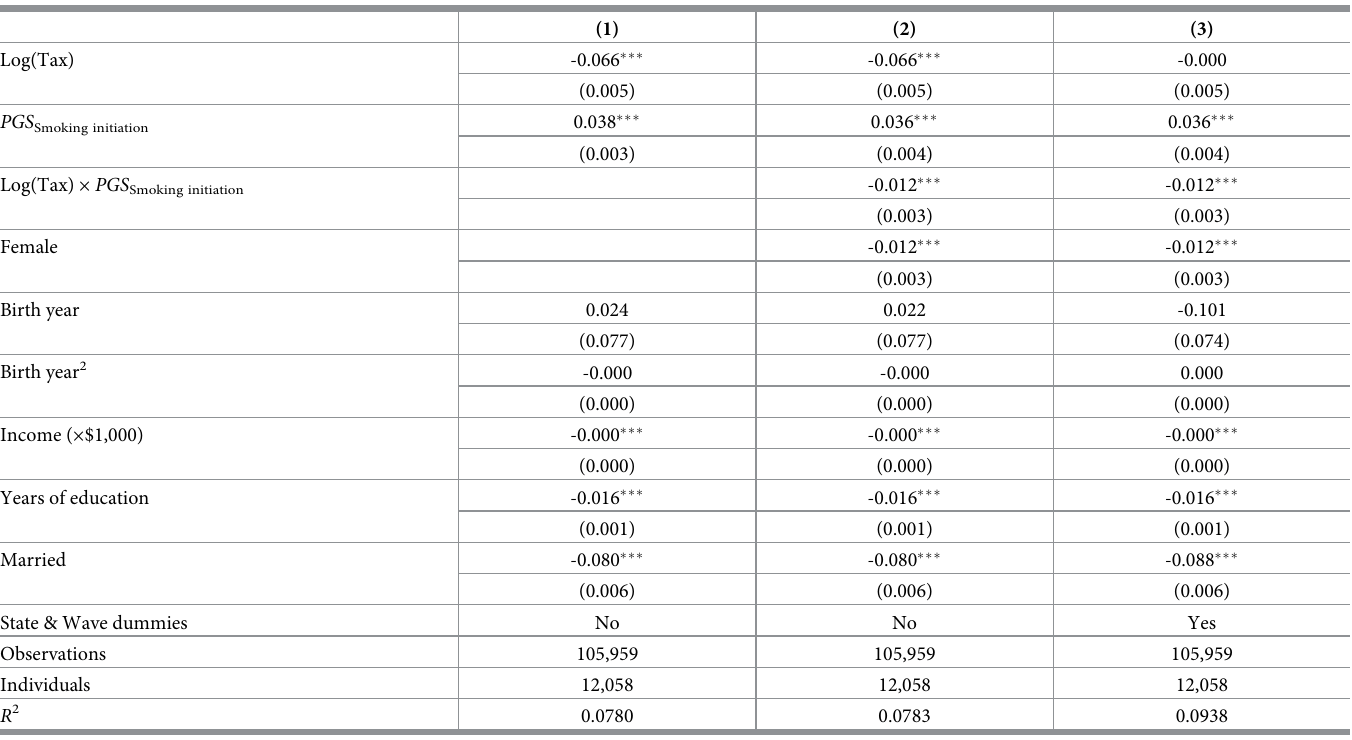
Table 2. Results of the regressions explaining an individual’s current smoking